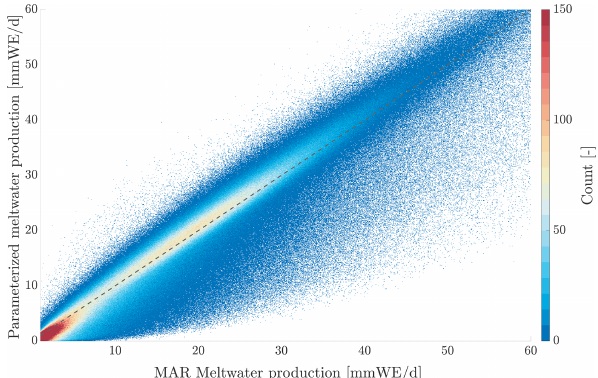
Figure 1. Linear regression of daily meltwater production simulated by MAR and parameterized meltwater production using modeled